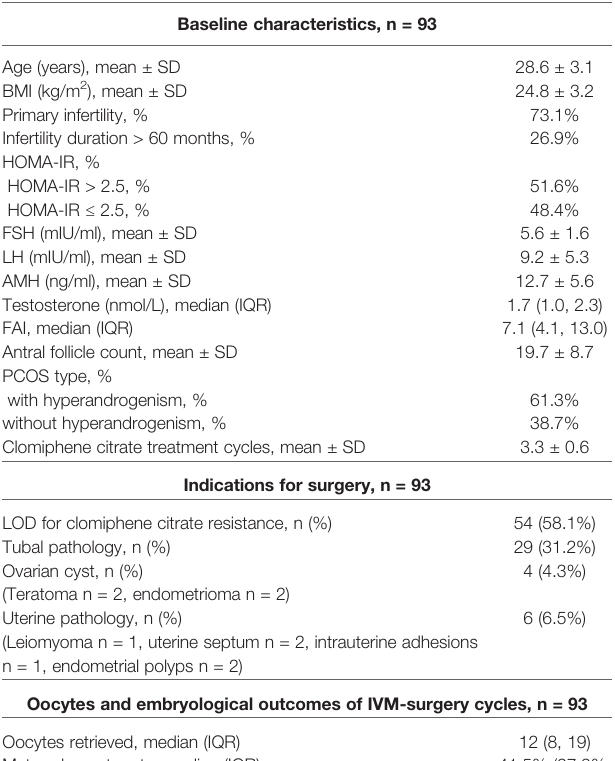
TABLE 1 | Characteristics of the study participants who underwent IVM-surgery. Baseline characteristics, n =